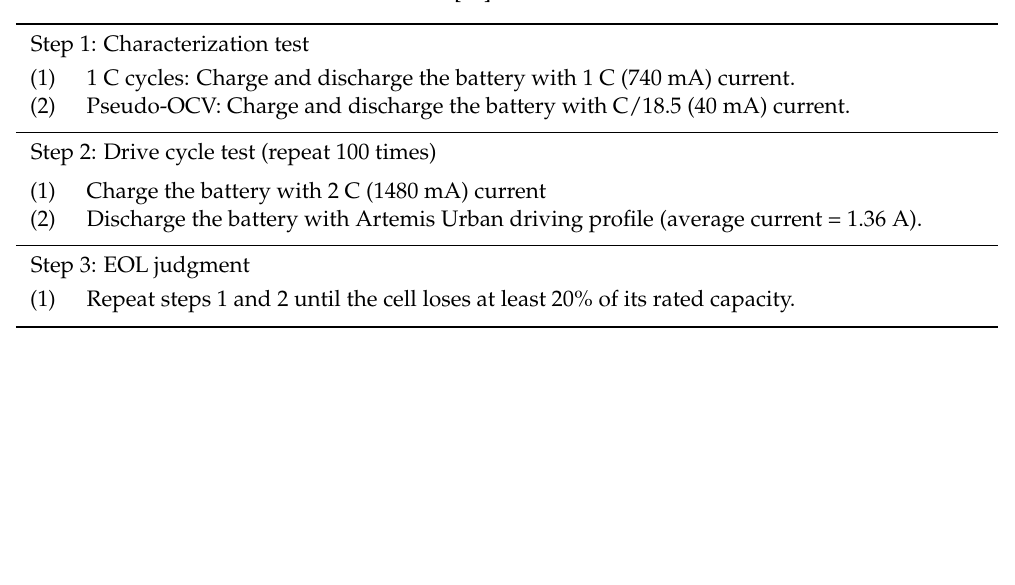
Table 1. Test schedule of the Oxford dataset